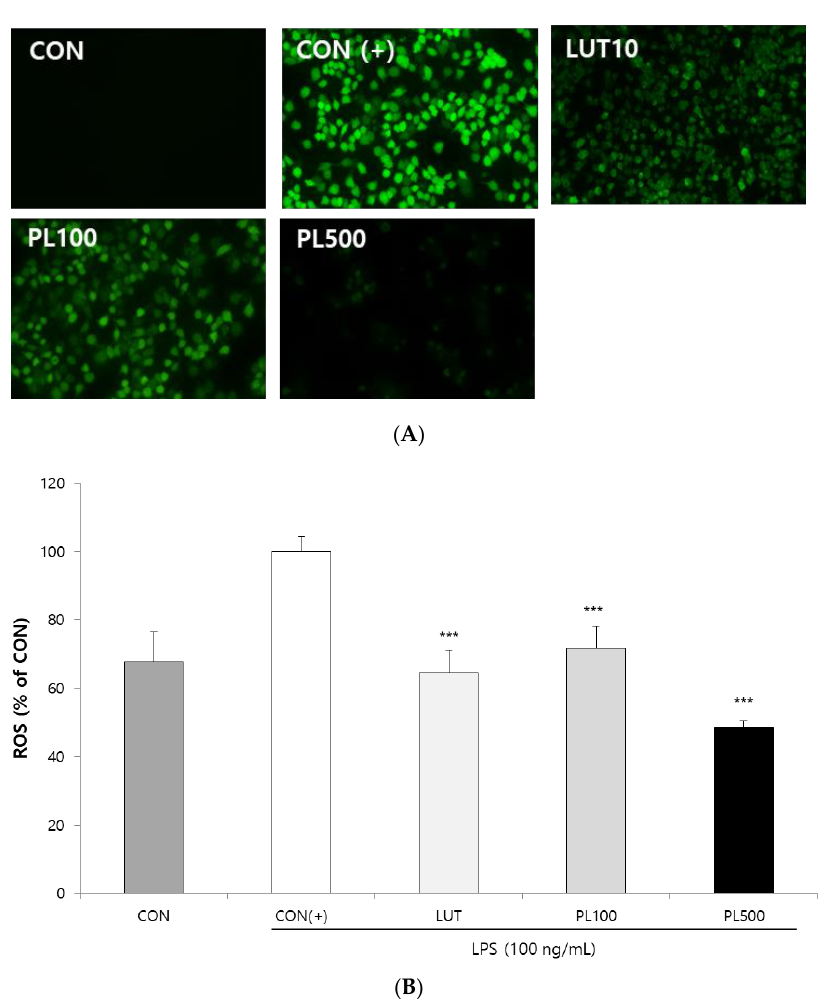
Figure 3. Pepper leaves (PL) extracts suppress reactive oxygen species (ROS) generation in lipopolysaccharide (LPS)-stimulated macrophages. ( A ) RAW 264.7 cells were treated with luteolin (LUT) 10 µM and various concentrations of PL extracts (100 and 500 µg/mL). Dichloro-dihydro-fluorescein diacetate (DCFH2-DA) was added to the culture medium at a final concentration of 50 µM. DCF fluorescence was imaged under a fluorescence microscope (100× magnification). ( B ) ROS inhibition rate, compared to control (+), was quantified by measuring the DCF fluorescence intensity. Statistical significance is based on the difference compared with CON (+) (* p < 0.05, ** p < 0.01, *** p < 0.001).